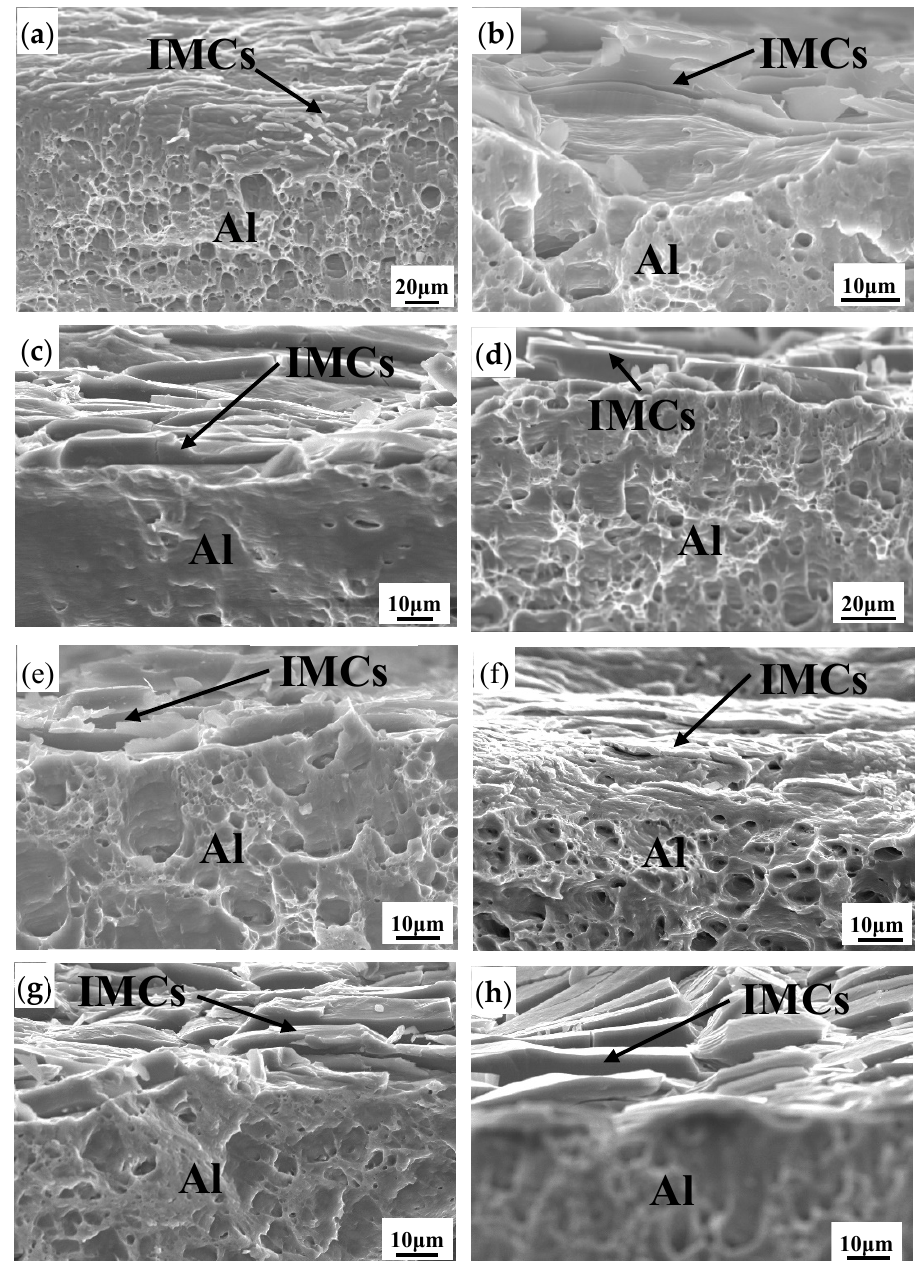
Figure 14. Fracture diagrams of flattened samples: ( a – d ) RD, ( e – h ) TD. ( a , e ) As-rolled; ( b , f ) 200 °C; ( c , g ) 300 °C; ( d , h ) 350 °C.